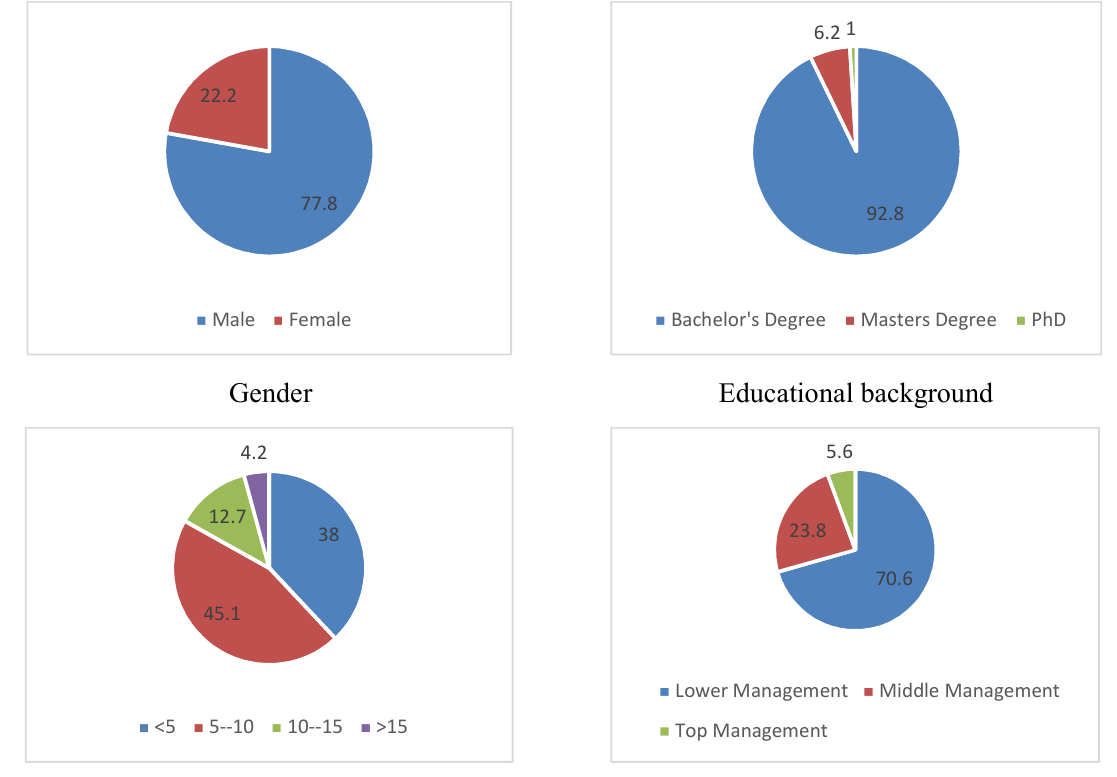
Fig. 2. Personal characteristics of the